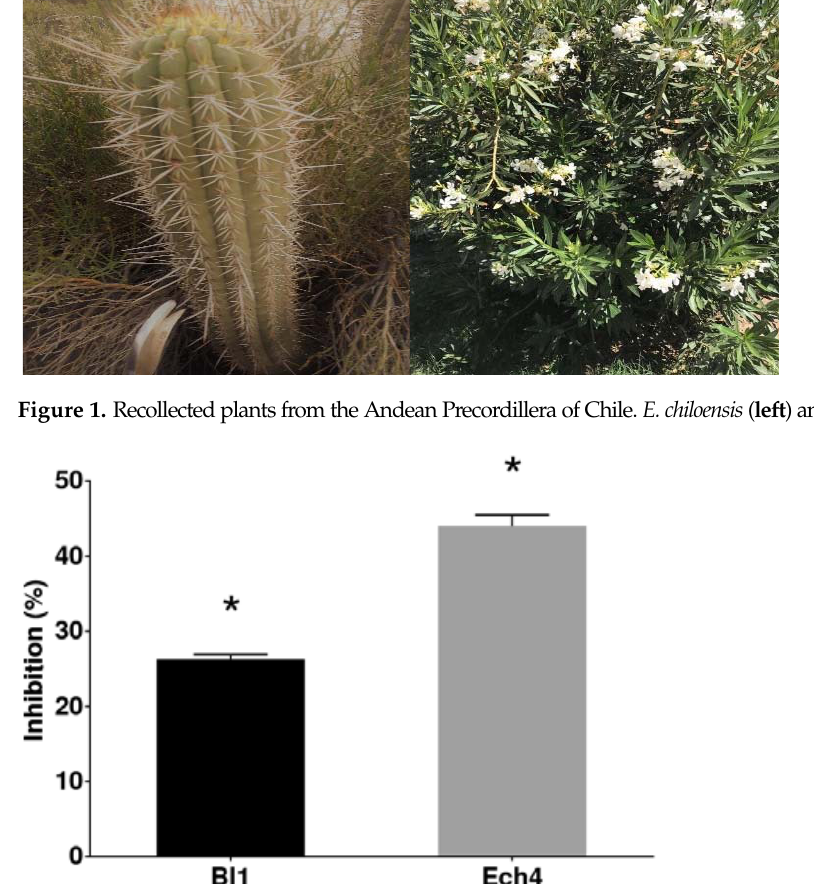
Figure 2. Antifungal effect of isolate Bl1 (black bar) and isolate Ech4 (grey bar) on B. cinerea growth. Each bar represents the average inhibition percentage of three experiments ± SD. Statistical signifi- cance when comparing treated groups and control group by multiple t-tests and Holm-Sidak method are indicated with asterisks ( p < 0.05). Table 1. Endophytes isolated from the recollected plants.